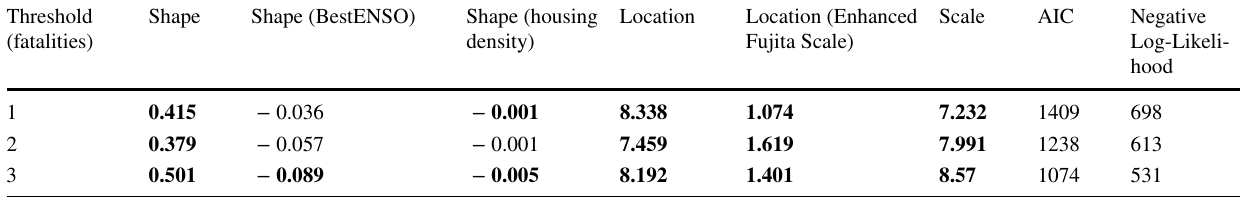
0.05 Bold indicates p value ≤ AIC Akaike’s information Table 4 Results of the estimated parameters for the point process (PP) nonstationary models with shape and location covariates